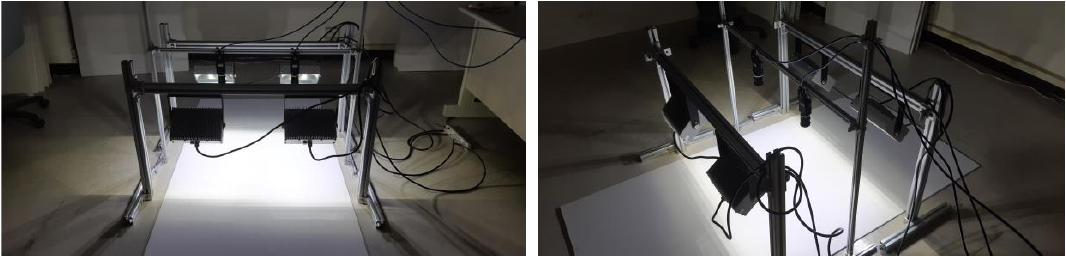
Figure 9. The process of collecting calcium silicate board (CSB) defect samples using the high-speed image capture platform.